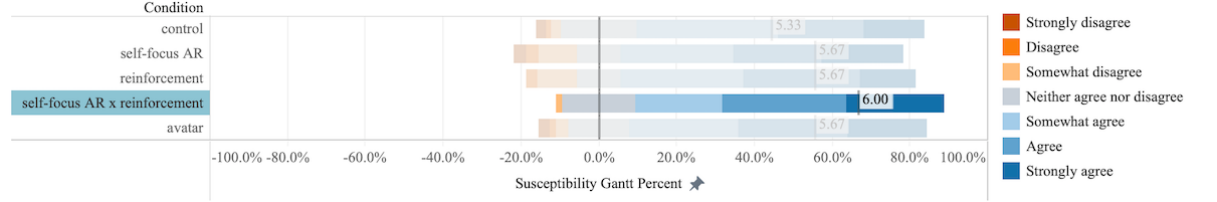
Figure 12. Significantly higher levels of perceived threat susceptibility among participants in the self-focus augmented reality (AR) × reinforcement condition compared to the control condition. No significant differences were found between the control group and the other